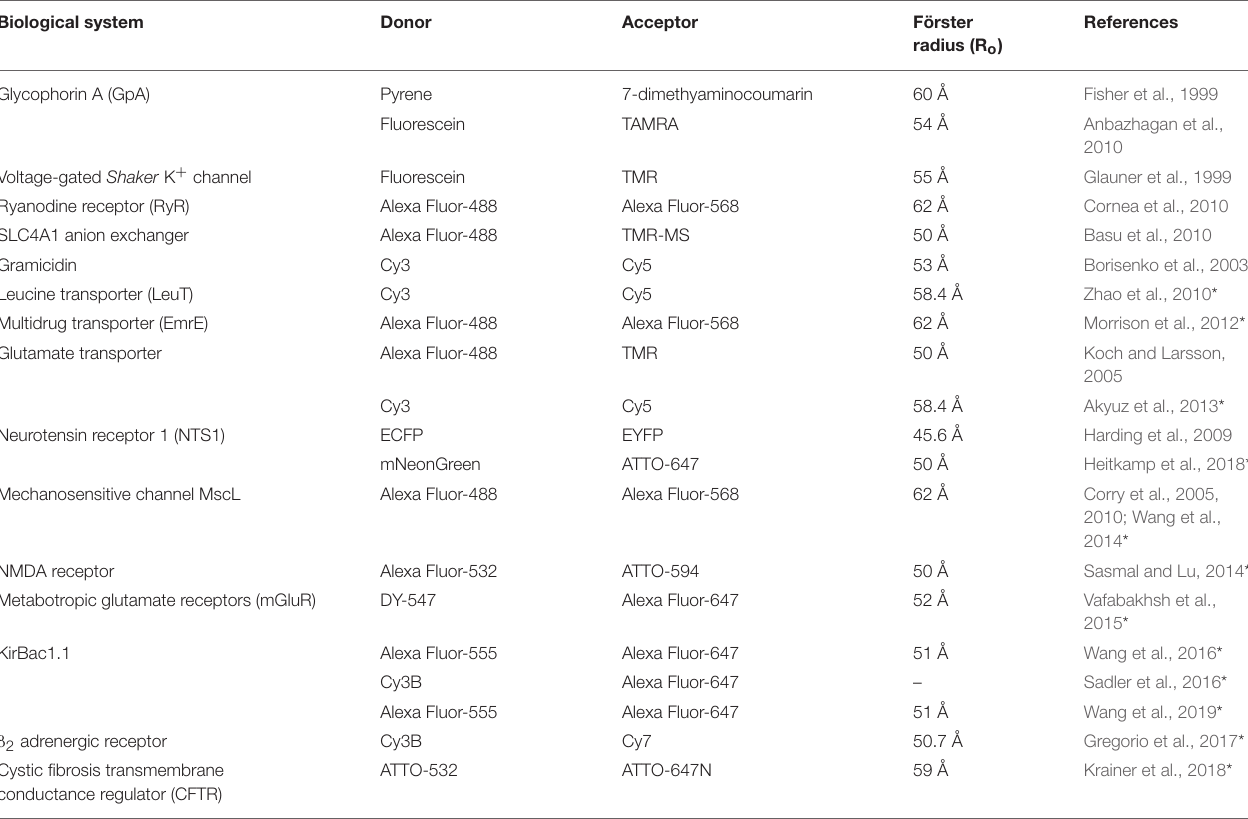
TABLE 1 | FRET studies of membrane